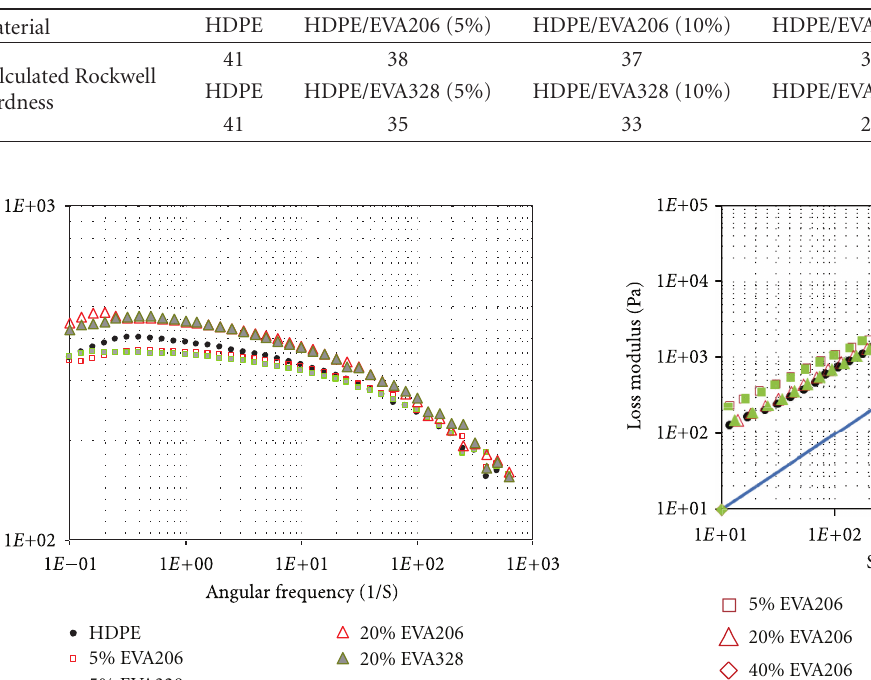
Table 2: Rockwell hardness of neat HDPE and its blends.